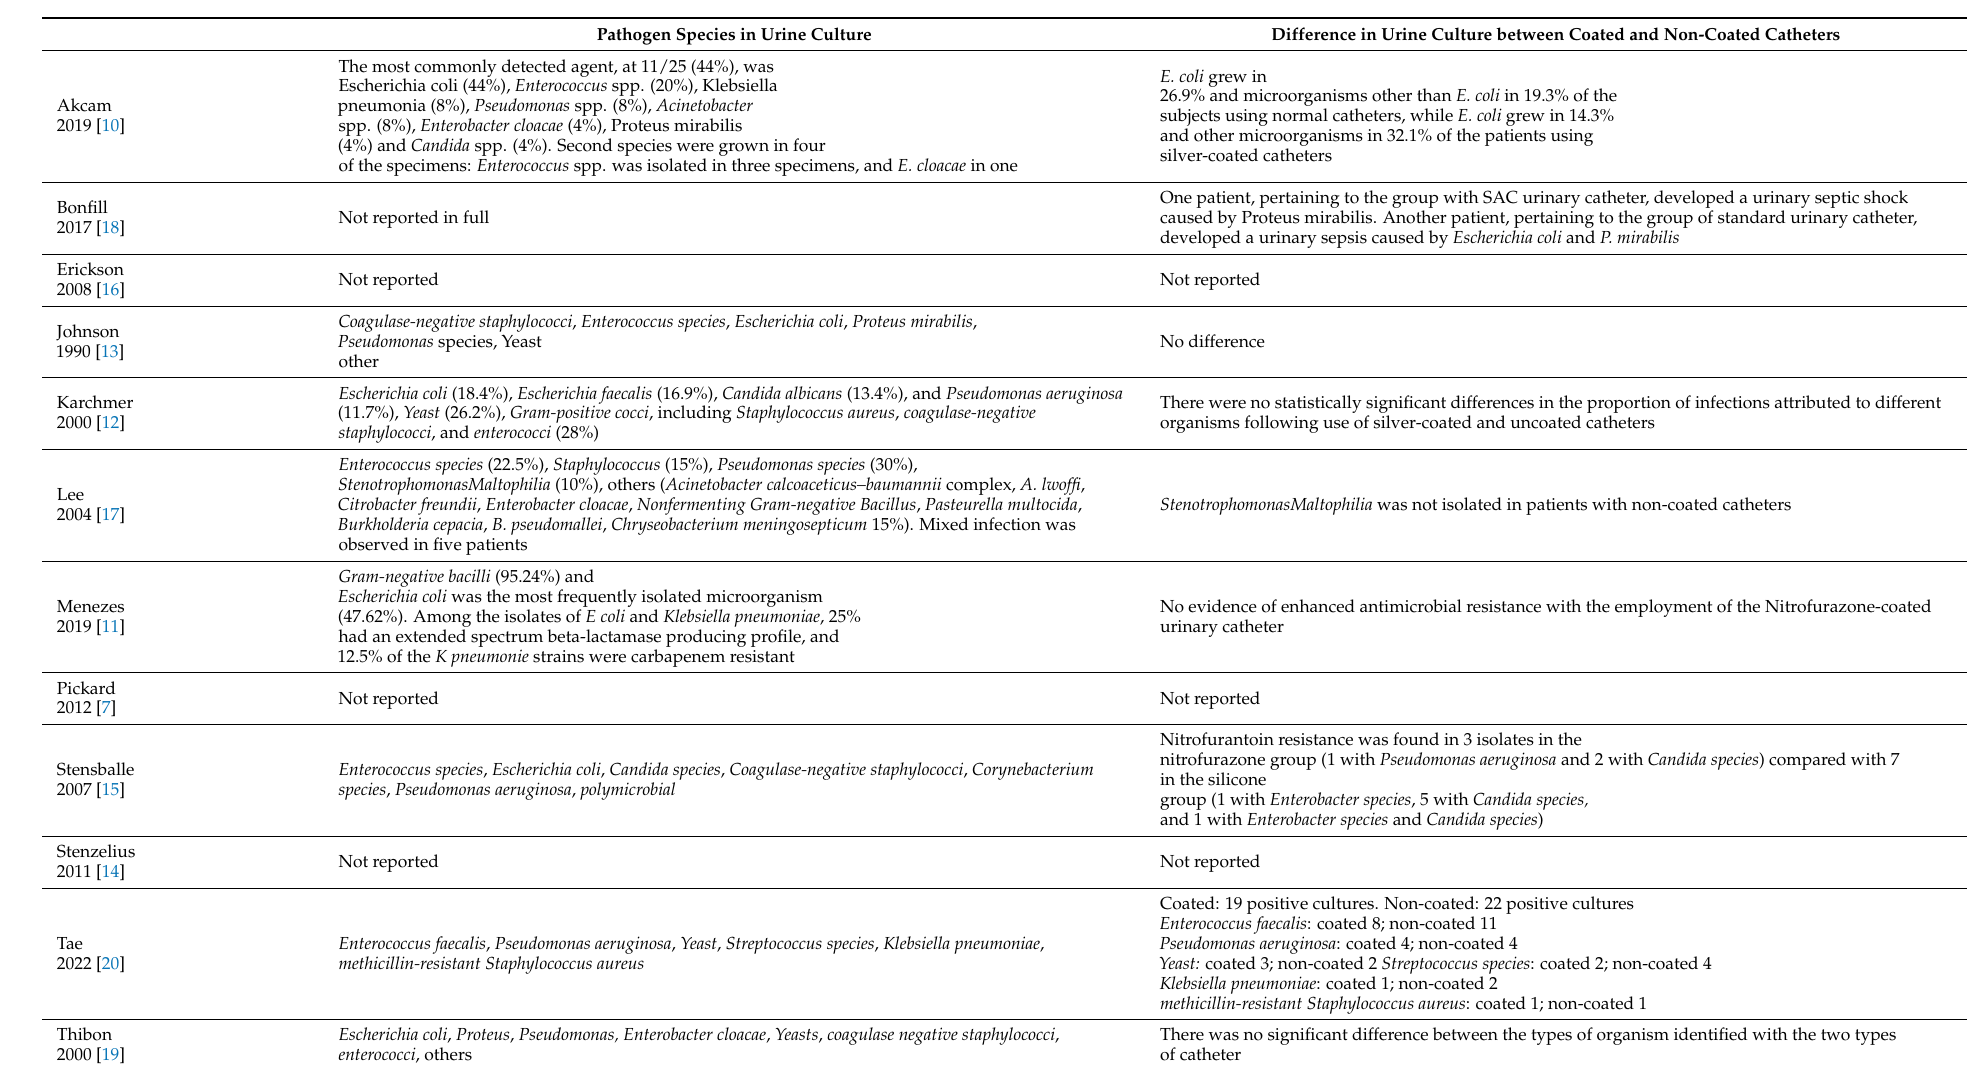
Table 2. Pathogens isolated in urine cultures. Pathogen Species in Urine